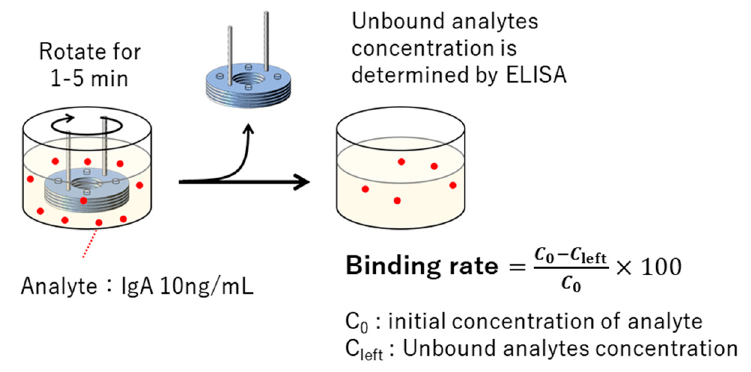
Figure 5. Process for evaluation of binding rate in a sandwich